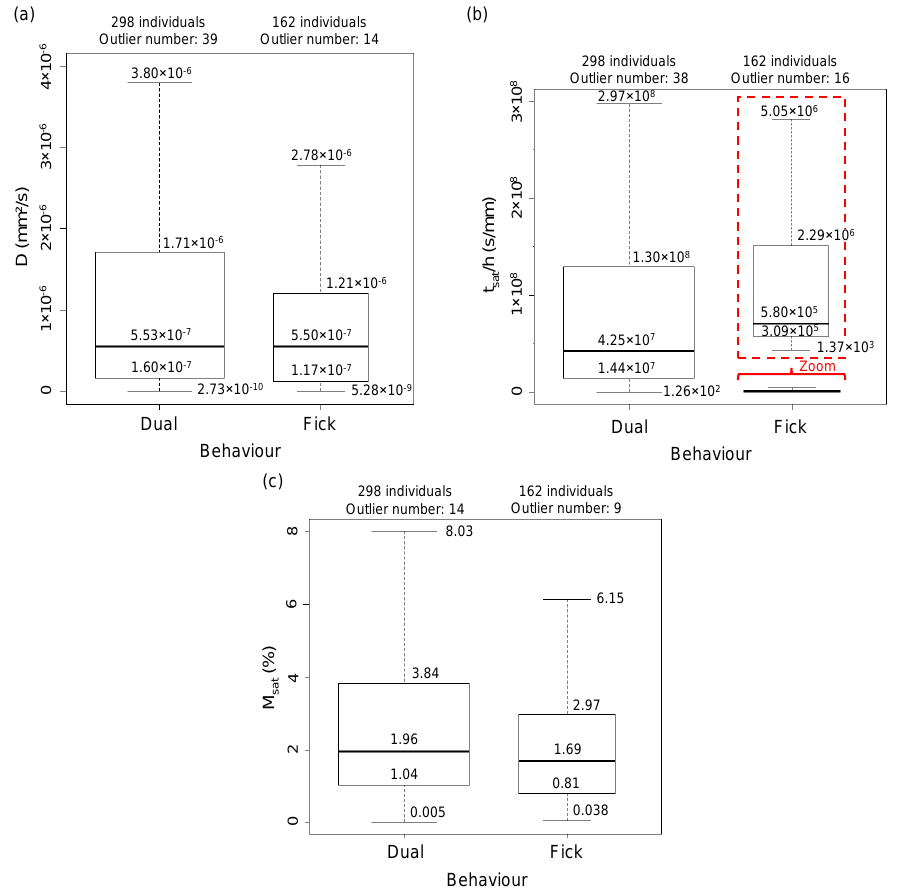
Figure 2. Box plots and characteristic values of ( a ) D , ( b ) t sat / h and ( c ) M sat as a function of the diffusion